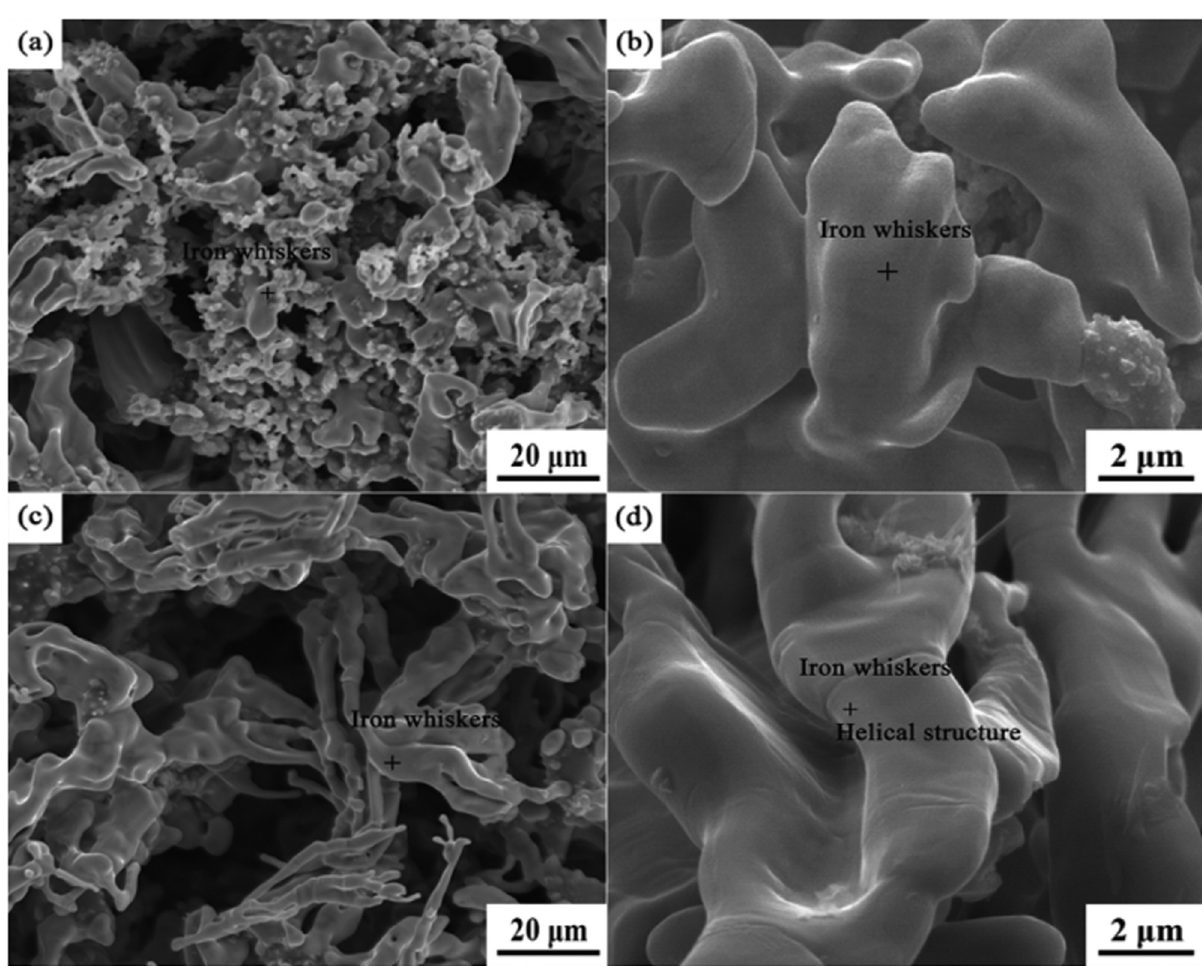
Figure 14: SEM images of reduced briquettes at the third stage. ( a and b ) 0 wt% ( K 2 O + Na 2 O ) , ( a and c ) on macrography, ( c and d ) 0.6 wt% ( K + Na ) , ( b and d ) on microcosmic. 2 O 2 O